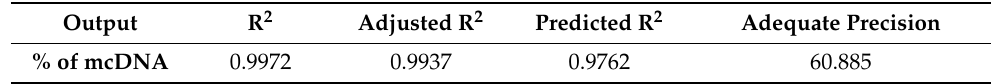
Table 2. Statistical coefficients of mcDNA optimization.